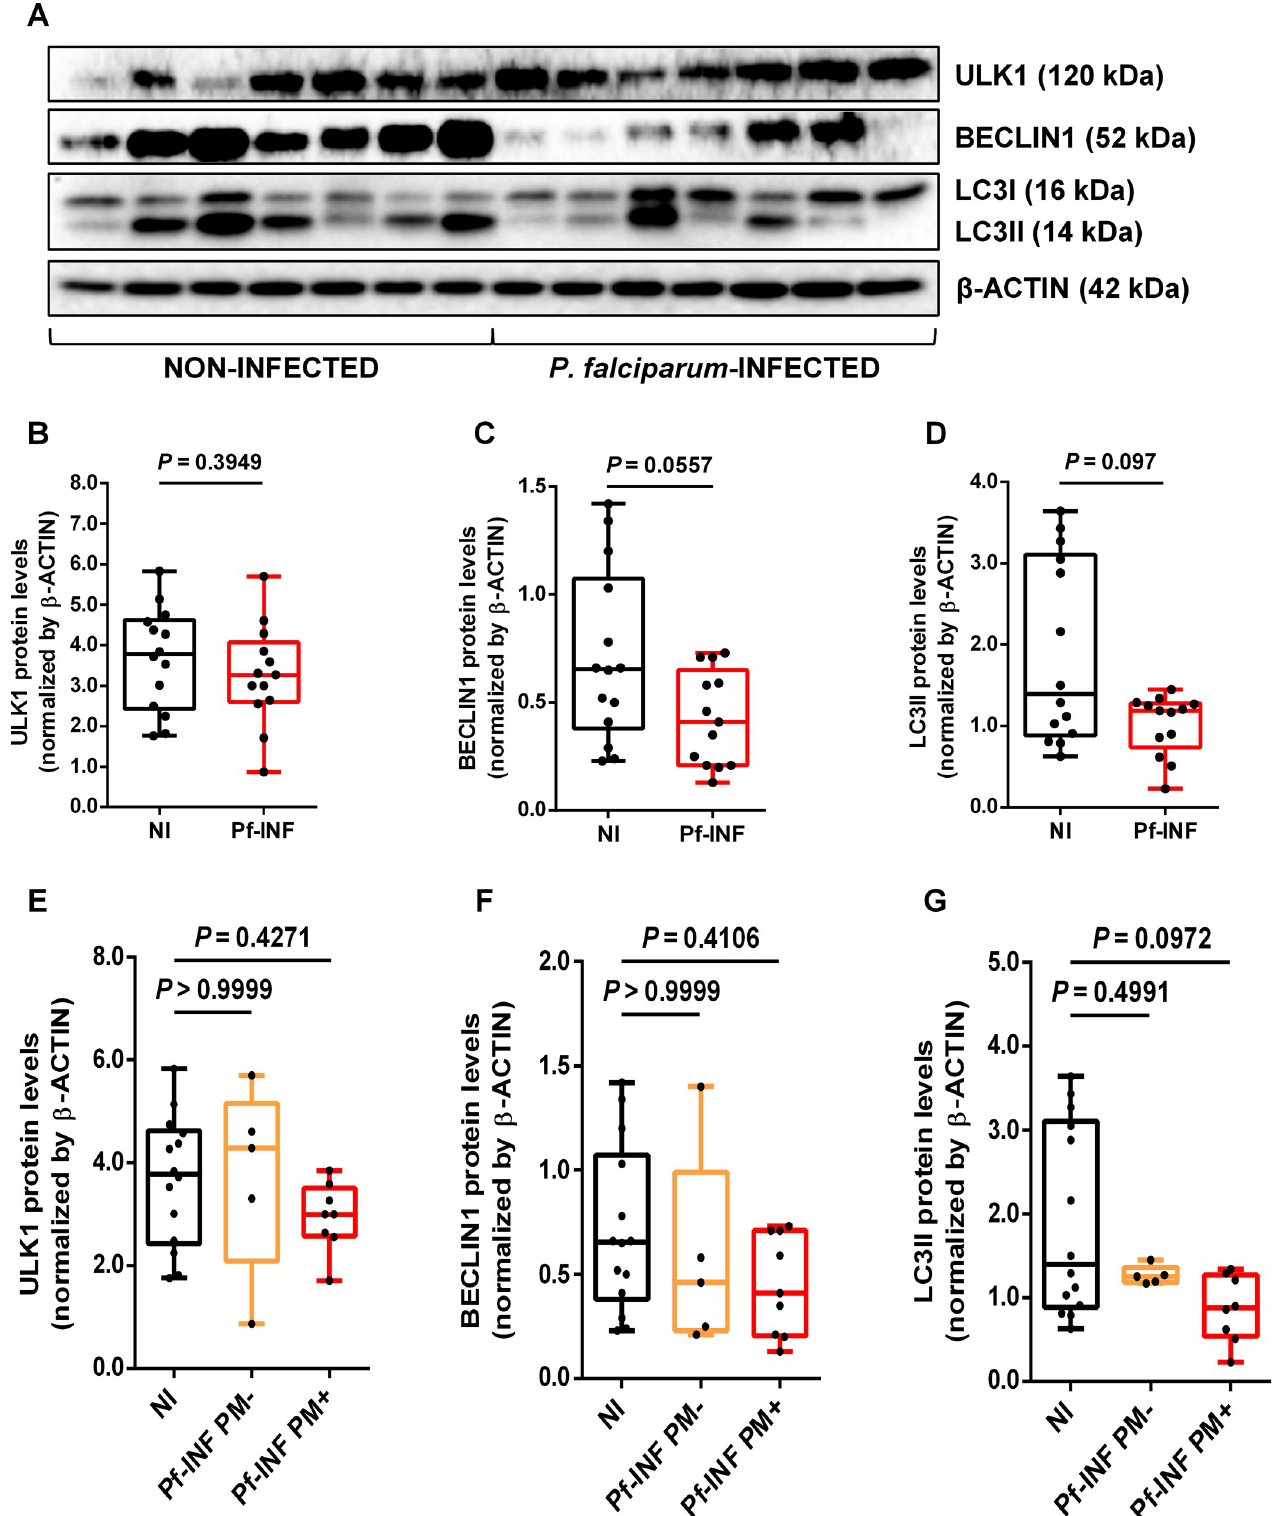
Fig 2. Levels of the autophagy-related proteins are diminished in P . falciparum -infected placentas. Placental autophagy-related protein levels measured in non-infected (NI) and P . falciparum -infected (Pf-INF) women. (A) Representative image of cropped western blotting of ULK1 (120 kDa), BECLIN1 (52 kDa),